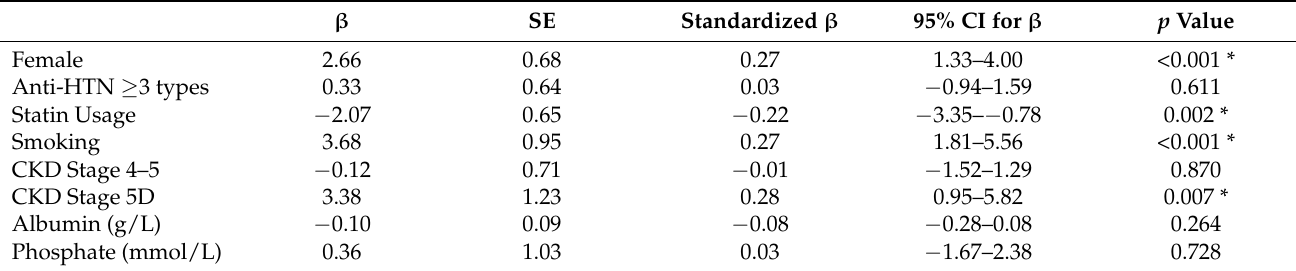
Figure 1. Forest Plots of BCL Associated Factors in CKD patients. ( a ) Middle BCL vs. Low BCL assessed by multinomial logistic regression analysis; ( b ) High BCL vs. Low BCL assessed by multinomial logistic regression analysis. Age, diabetes, and covariates with a p value ≤ 0.05 in univariate analyses were adjusted for analysis. Anti-HTN ≥ 3, antihypertensives ≥ 3 types; BCL, blood cadmium level; CKD, chronic kidney disease; CKD 5D, chronic kidney disease stage 5D; CKD 4–5, chronic kidney disease stage 4–5; CI, confidence interval; OR, odds ratio. Table 4. Multiple Linear Regression Analysis of BCL (nmol/L) Associated